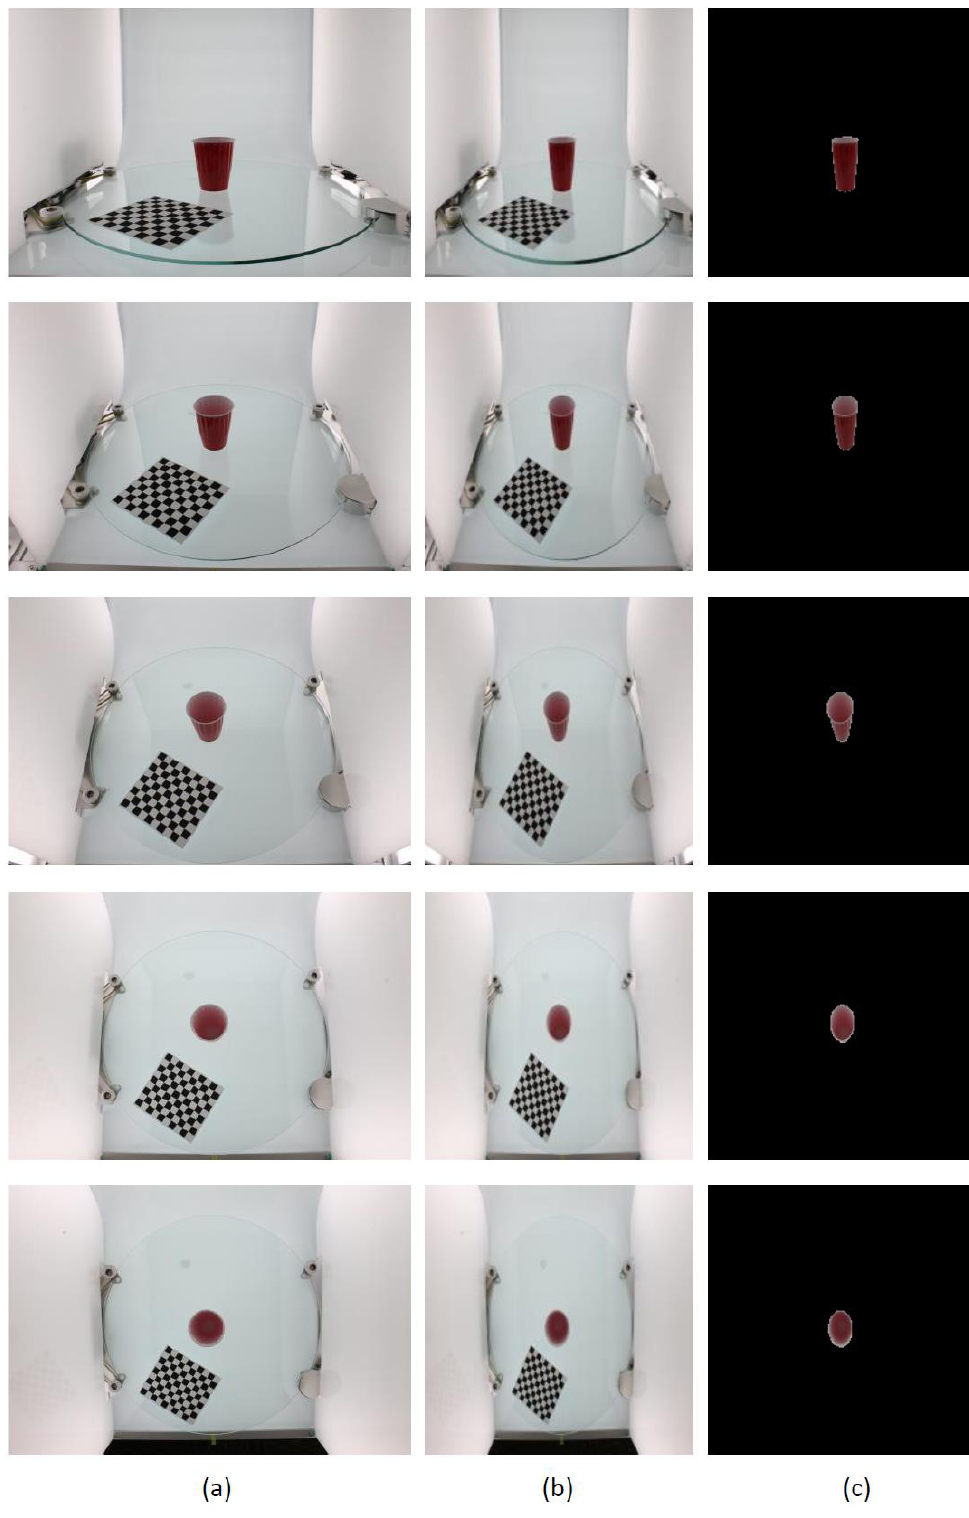
Figure 8. GrabCut-based segmentation experiment results for ikea_table_red_cup object: ( a ) original input image; ( b ) image after resizing; ( c ) GrabCut method segmentation